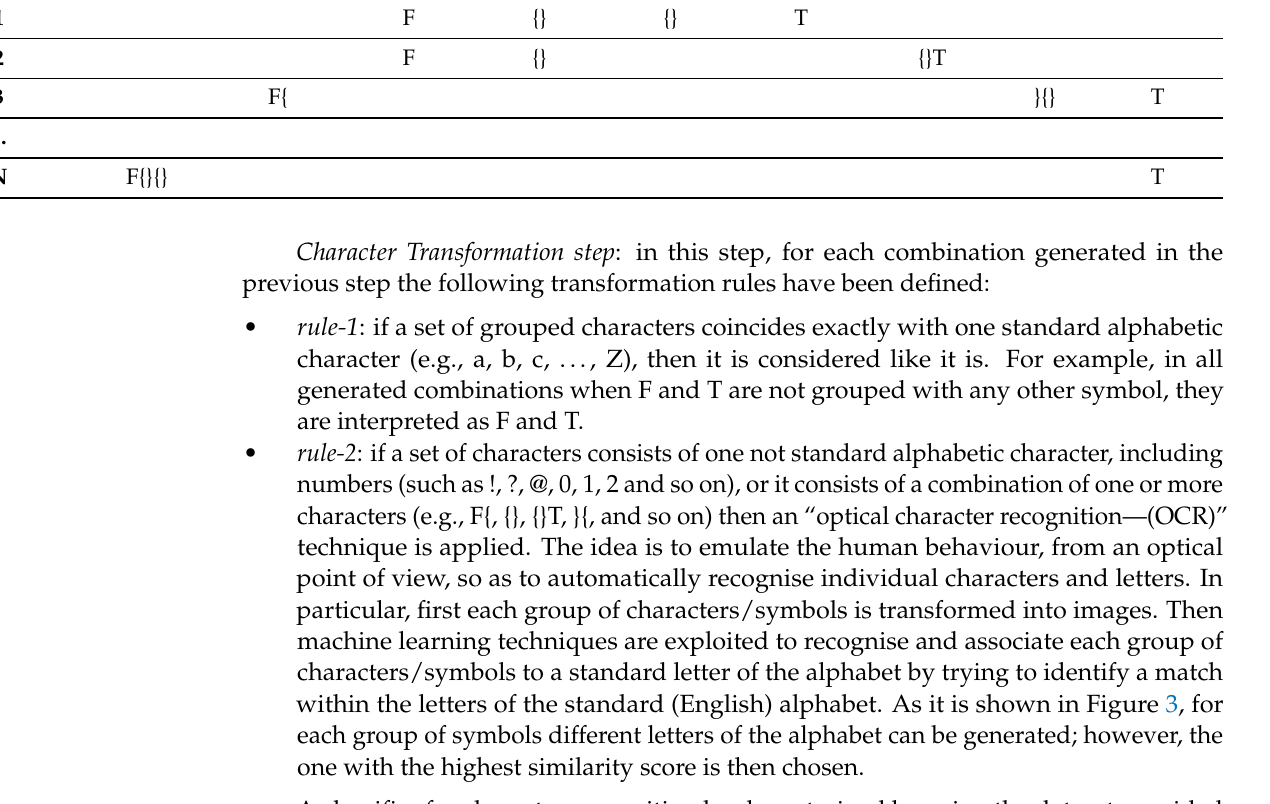
Table 3. An example of segregation with Art Form Word (AFW) = “ F{}{}T ”. Combination